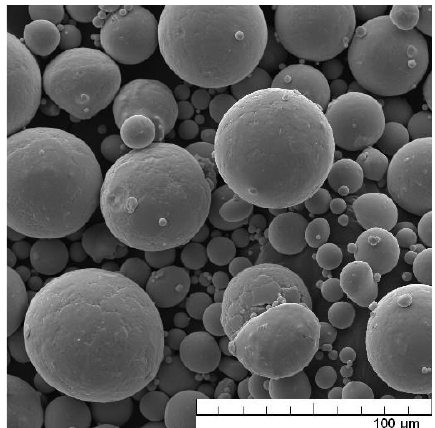
Figure 1. Morphology of the initial powder of Ti-25Nb-4Ta-8Sn alloy prepared by gas atomization (SEM).